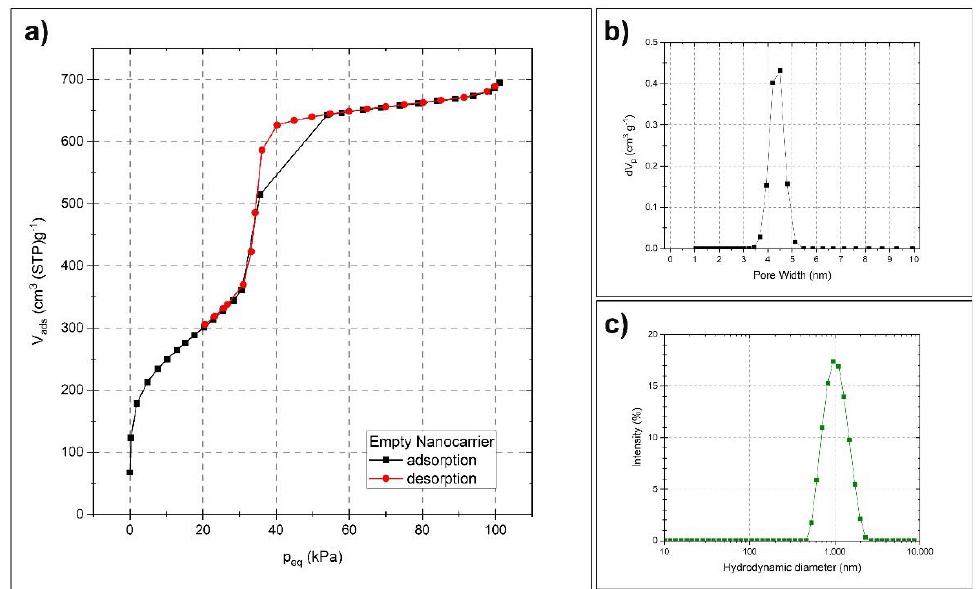
Figure 3. Characterization of the nanocarriers by nitrogen sorption and dynamic light scattering. Nitrogen physisorption isotherm ( a ), pore size distribution plot ( b ), and hydrodynamic size distribution of the particles ( c ).